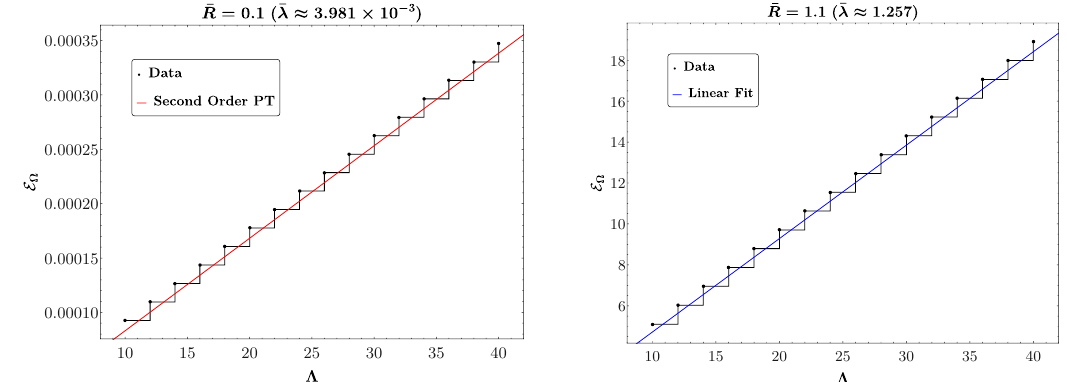
Figure 15. Vacuum energy as a function of the cutoff in the Lee-Yang model. The black dots are the Hamiltonian truncation data: since the vacuum is parity even, the Hamiltonian needs to be diagonalized anew only when Λ jumps by an even integer. In the left plot, the solid red line is eq. (5.26). In the right plot, the solid blue line is a fit to the